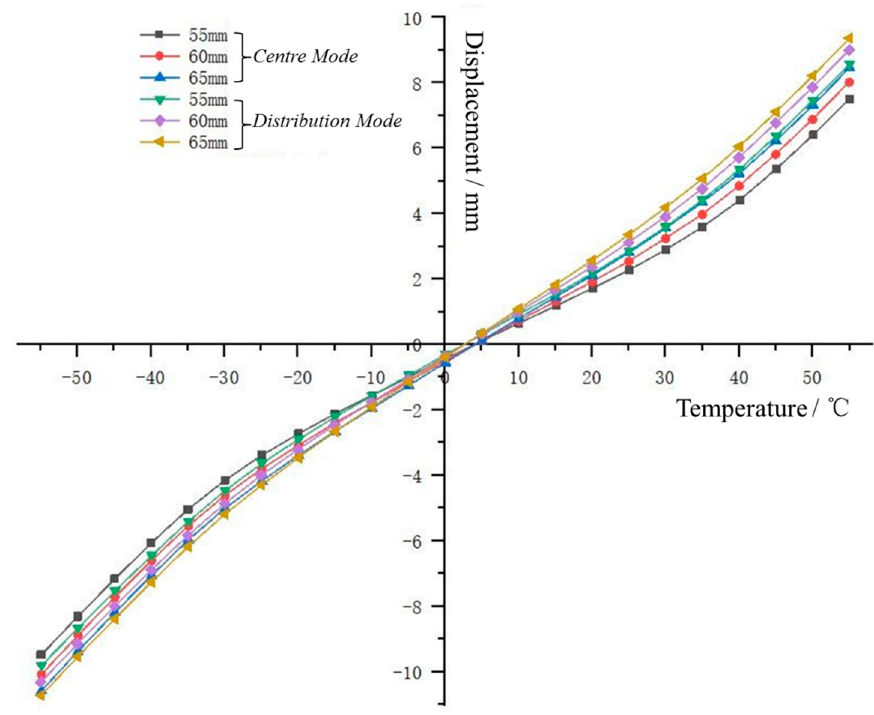
Figure 8. Displacement–temperature curve of bellows with different wave heights.